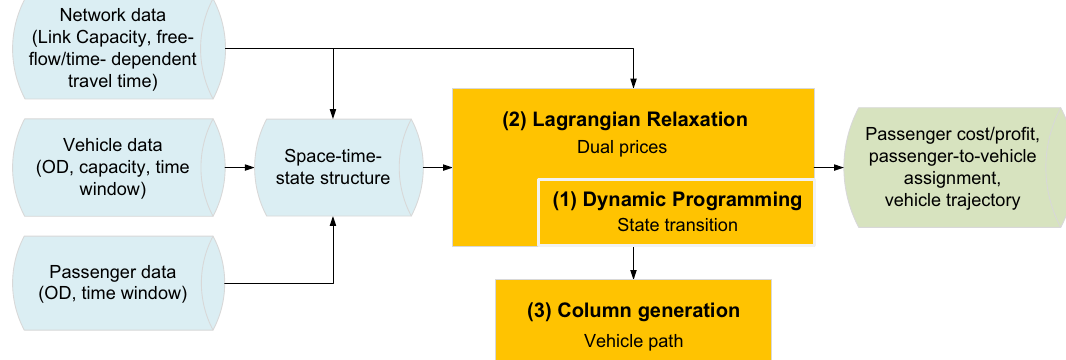
Fig. 2 Software architecture with key modeling